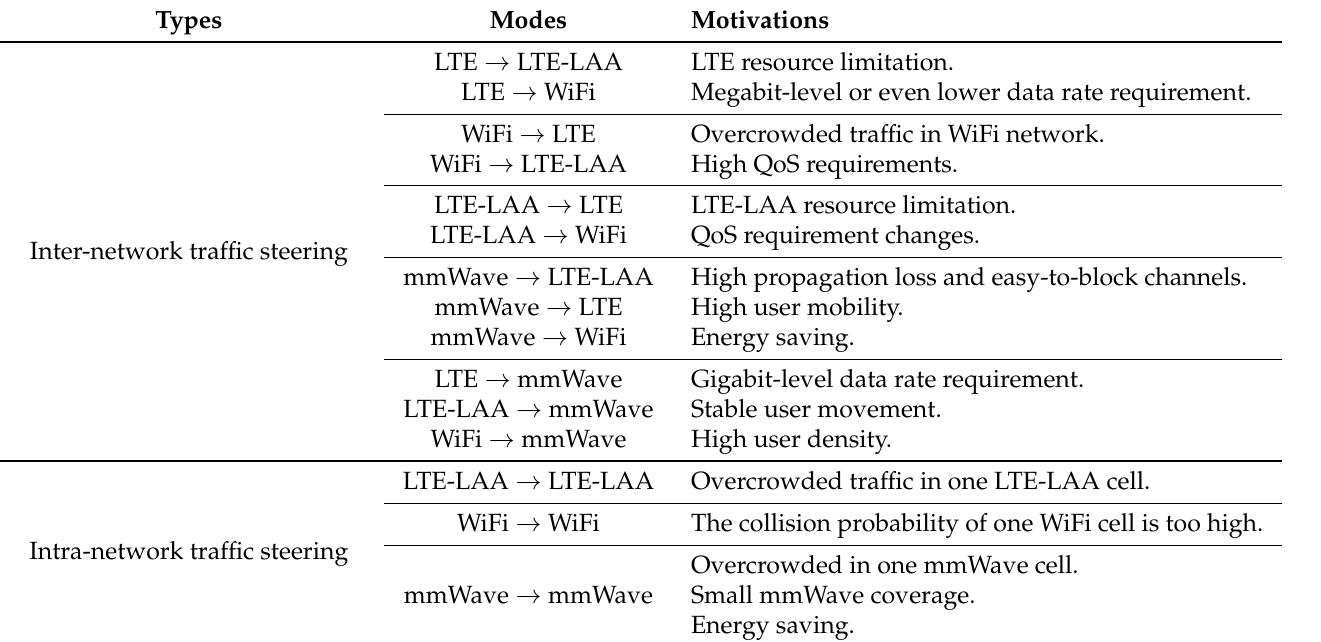
Table 2. Traffic steering modes in the proposed mmWave